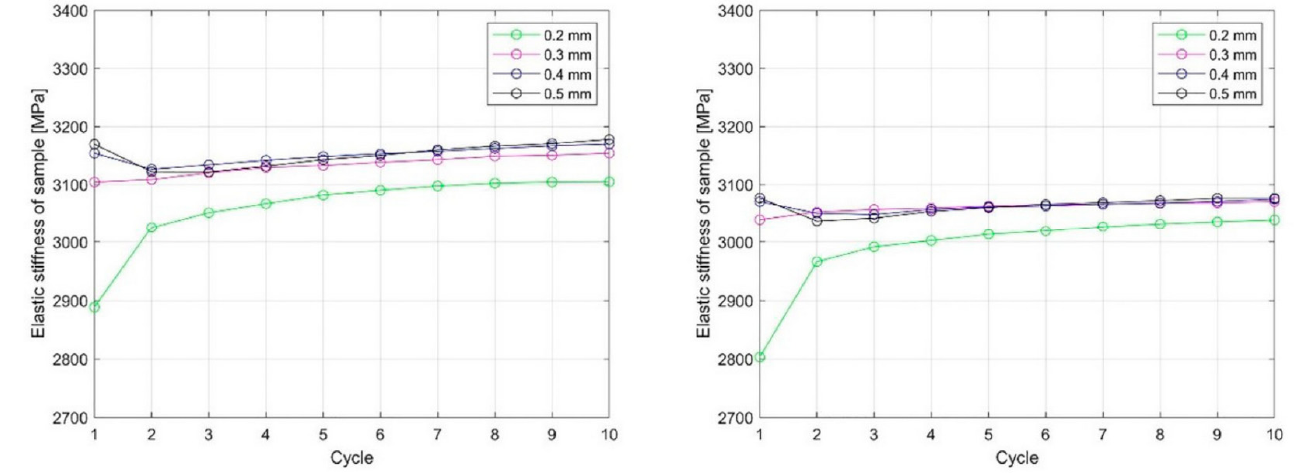
Figure 5. Influence of cyclic plastic loading on modulus of elasticity [34].